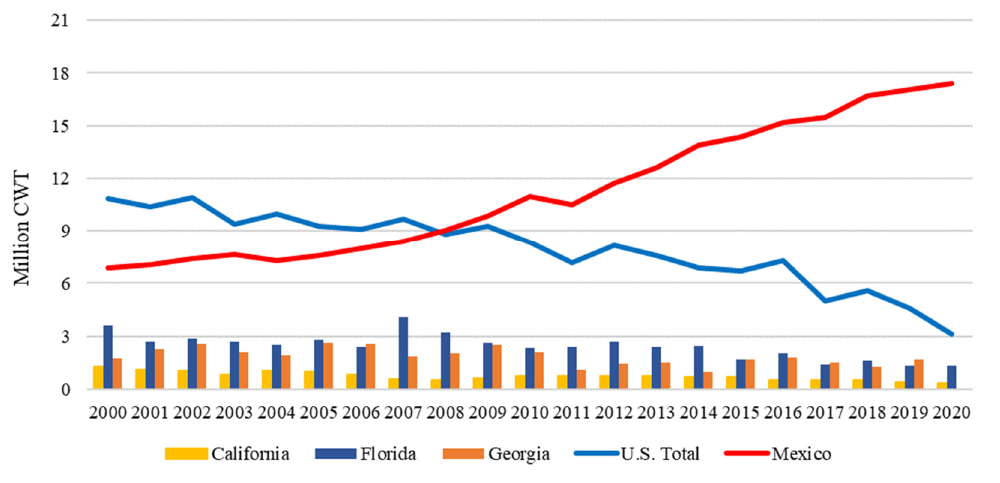
Figure 13. U.S. production and Mexican imports: fresh market cucumbers. Notes: (1) The fresh cucumber production data of California in 2016 and 2017, Florida in 2018 and 2019, and Georgia from 2017 to 2019 are undisclosed and calculated based on the percentages of fresh cucumbers from avail- able data; on average, 36% of California, 39% of Florida, and 93% of Georgia were sold to the fresh market. (2) The 2020 Georgia data are not presented in the figure because neither the fresh market nor total production data of Georgia in 2020 is available. Sources: USDA FAS [11] ; USDA NASS [37] .